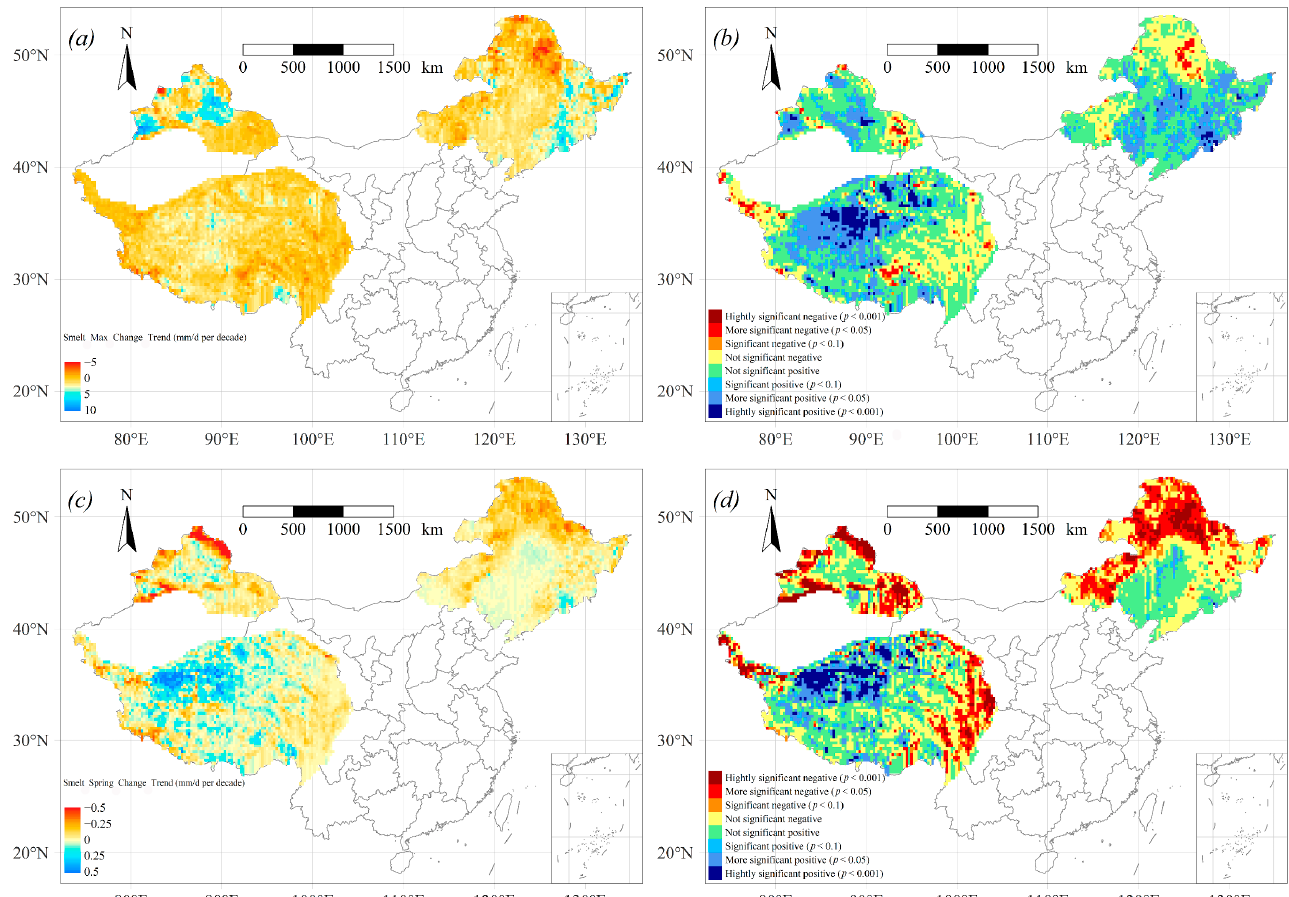
Figure 4. Spatial variation in the changed snowmelt rate in spring across the three main stable snow cover regions of China between 1981 and 2020. Distributions of the trends for the ( a ) maximum snowmelt rate and ( b ) its corresponding significance levels ( t -test), and for the ( c ) mean snowmelt rate and ( d ) its corresponding significance levels ( t